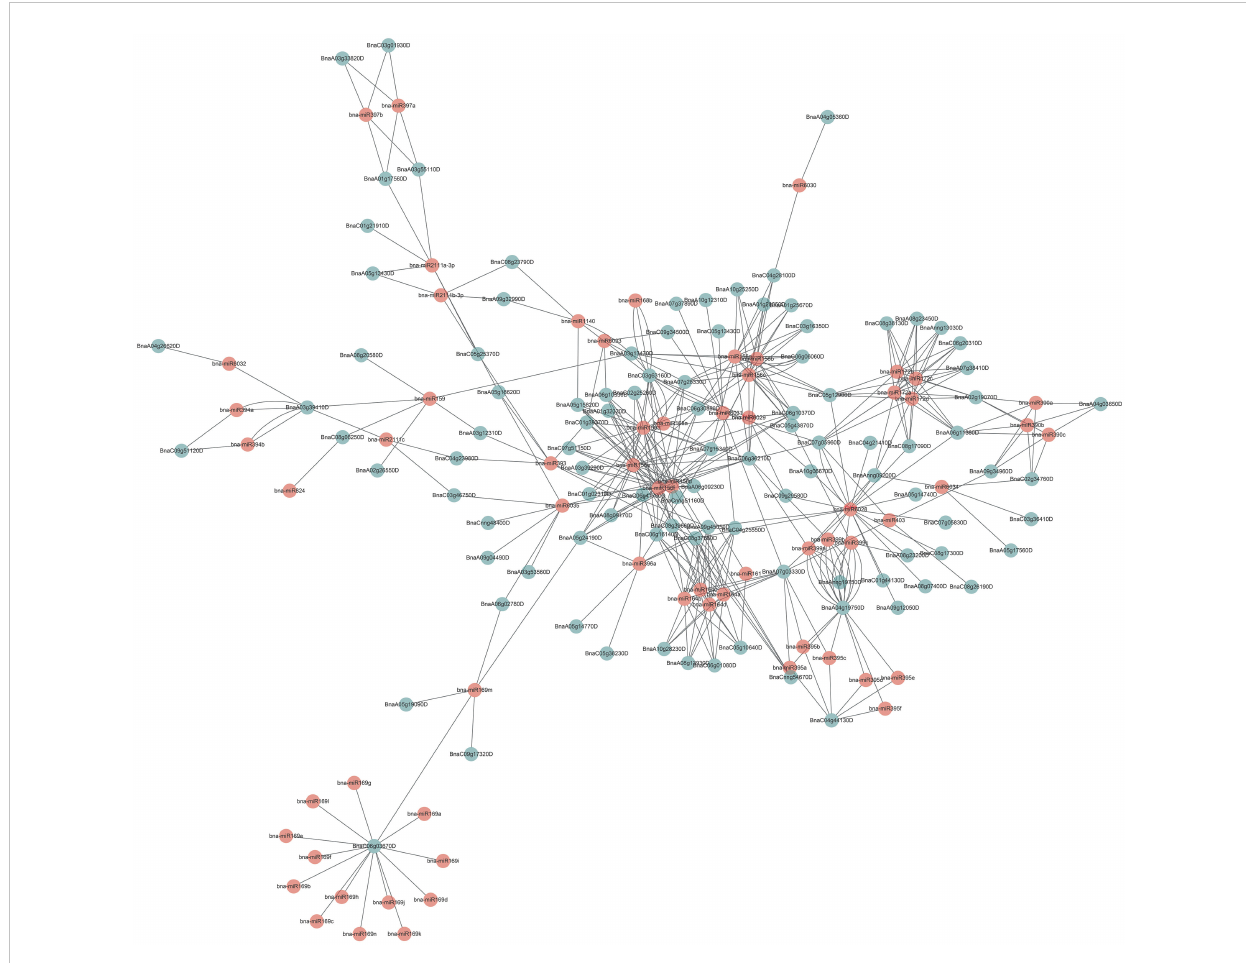
FIGURE 6 Schematic representation of the interaction network between the miRNAs and their putative BnUBC